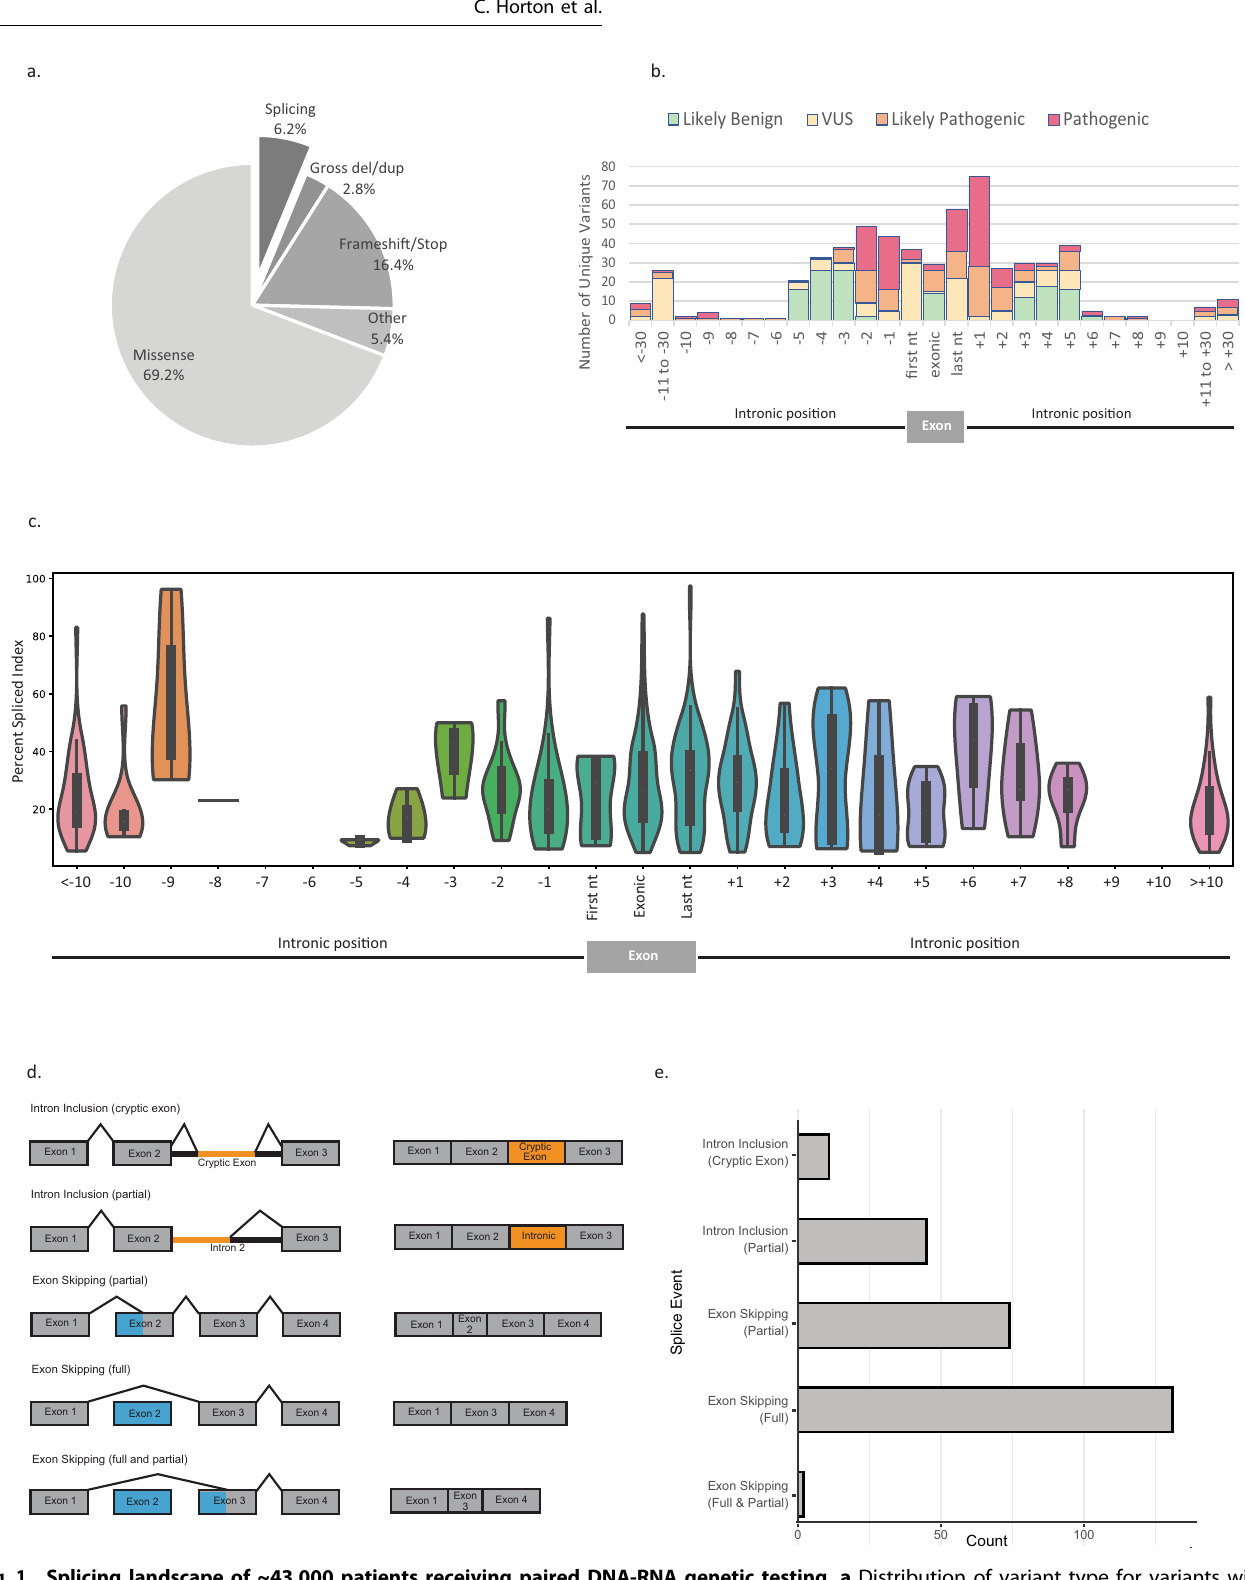
Fig. 1 Splicing landscape of ~43,000 patients receiving paired DNA-RNA genetic testing. a Distribution of variant type for variants with classi fi cation of VUS, LP, or P ( N = 15,288 reported DNA variants); b Splicing variant classi fi cation by nucleotide position ( N = 555 unique splicing variants among 7136 unique total DNA variants); c Violin plots demonstrating the percent spliced index of splicing events associated with variants (P/LP/VUS) in patients ( N = 516 DNA/RNA associated variants), with comparison to their median in healthy donor controls shown in Supplemental Fig. 1. Within each violin, the white dot represents the median, the boundaries of the thin black rectangle represent the interquartile range, and the black line extending from the rectangle represents 1.5× interquartile range; d Schematic of the splicing event types considered (gold, inclusion of intronic sequence; blue, exclusion of exonic sequence); e Distribution of splicing events associated with reportable variants by splicing event type ( N = 263 unique transcripts). Variant of Unknown signi fi cance (VUS), Likely Pathogenic (LP), Pathogenic (P), nucleotide (nt), Percent Spliced Index (PSI), Deletion/Duplication